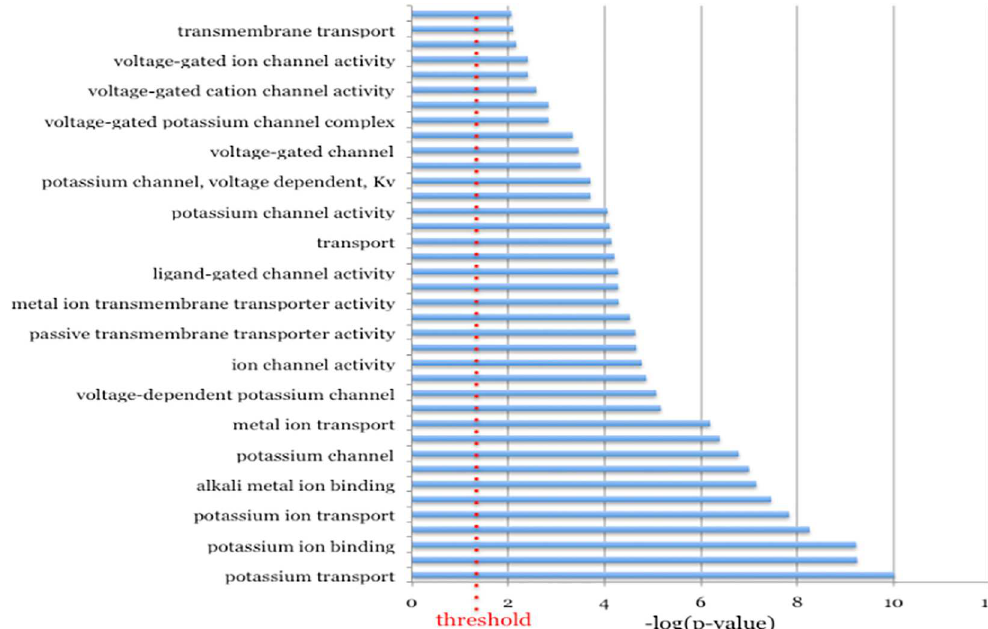
Fig 3. The overrepresented molecular function categories for the hit list. The–log(p-value) is plotted with 0.05 being the significance threshold.